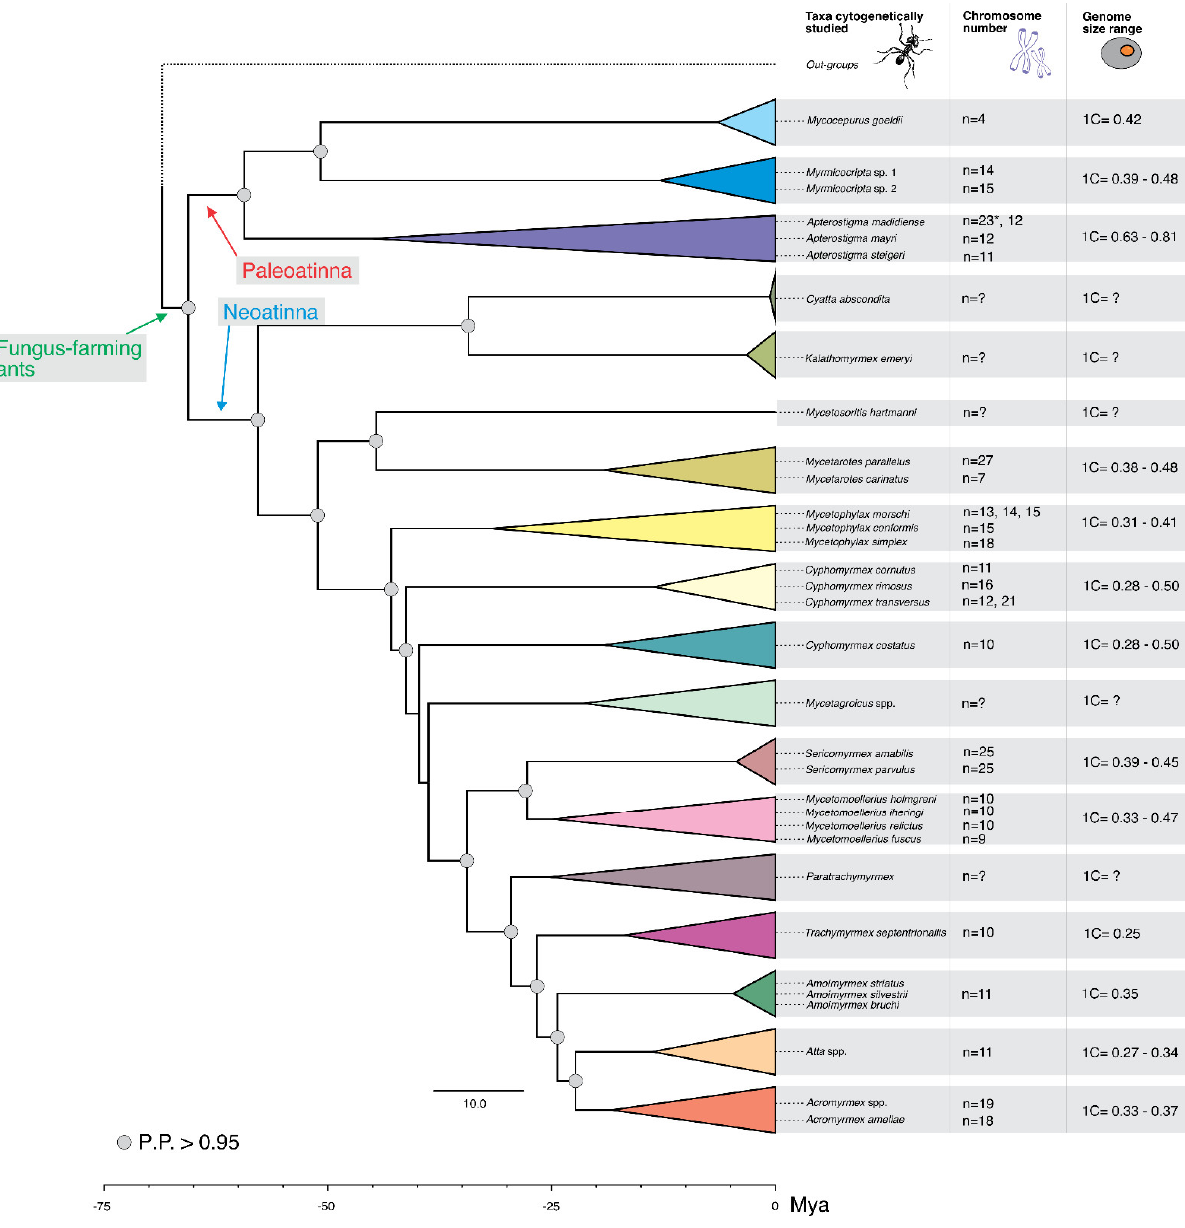
Figure 6. Cytogenetic information regarding fungus-farming ants mapped on the time-calibrated phylogenetic tree of subtribe Attina (Myrmicinae) aiming genera. Available chromosome numbers and genome size for certain taxa are given (data refer to Table 5). Asterisk: previously published chromosome report that differs from the number published in the present study.